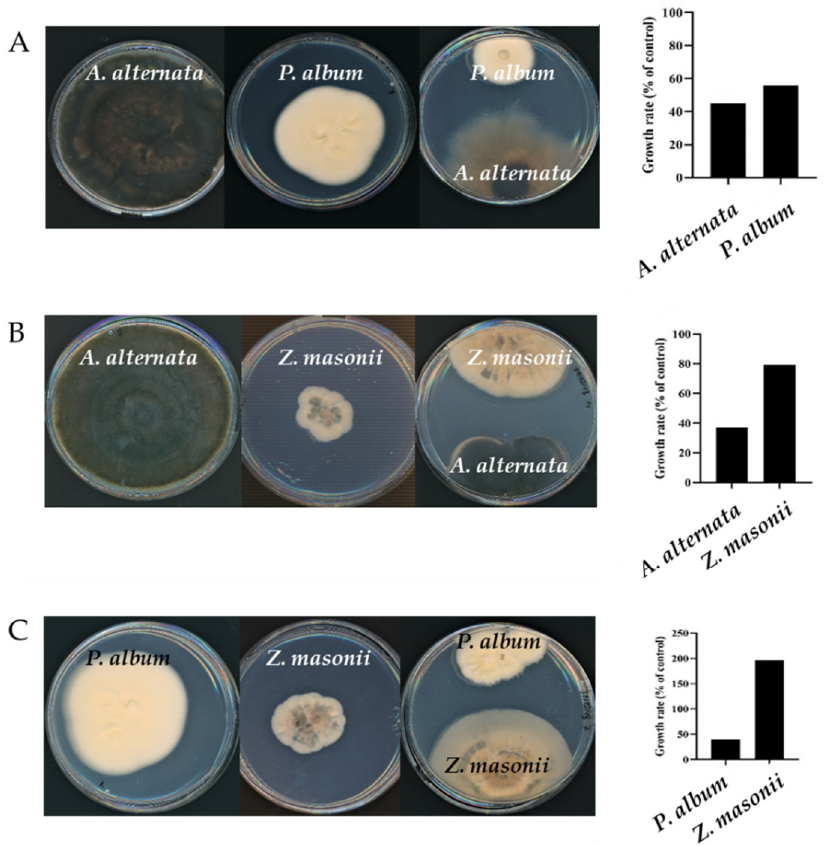
Figure 4. Growth of the A. oroides mycobiome constituents Parengyodontium album, Alternaria alternata and Zygosporium masonii in single and dual cultures. Pictures and measurements were carried out 12, 9 and 18 days after inoculation, for panels ( A – C ), respectively. Within each panel, differences in growth rates are significantly different ( p ≤ 0.01).